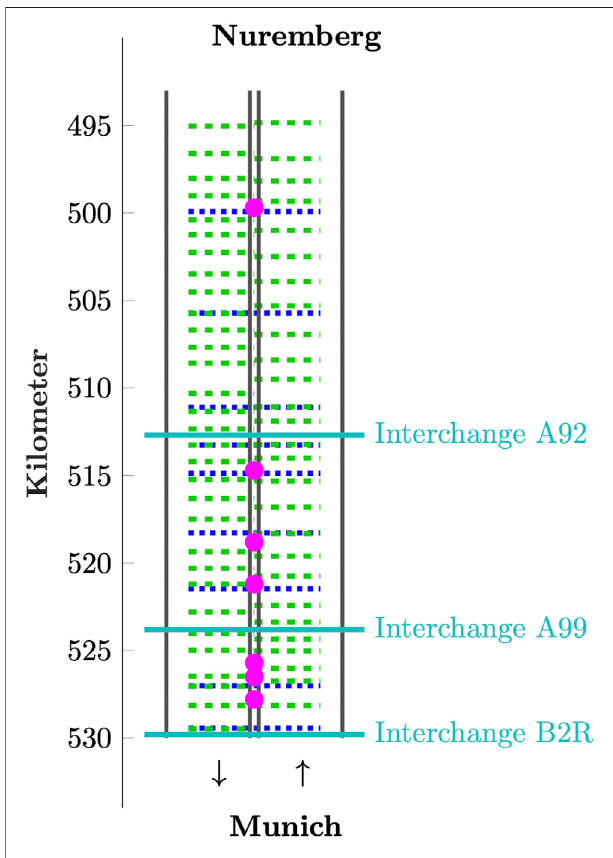
FIGURE 1 | Sketch of considered road stretch: interchanges (cyan), ramps (magenta), induction loops (dashed green), Bluetooth (dotted blue); FCD available all throughout the